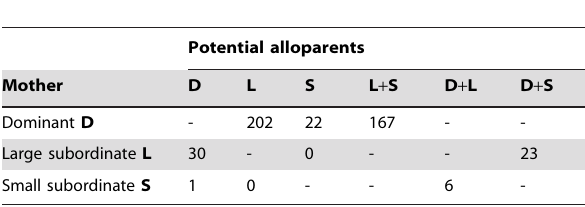
Table 1. Sample sizes of brood care observations per